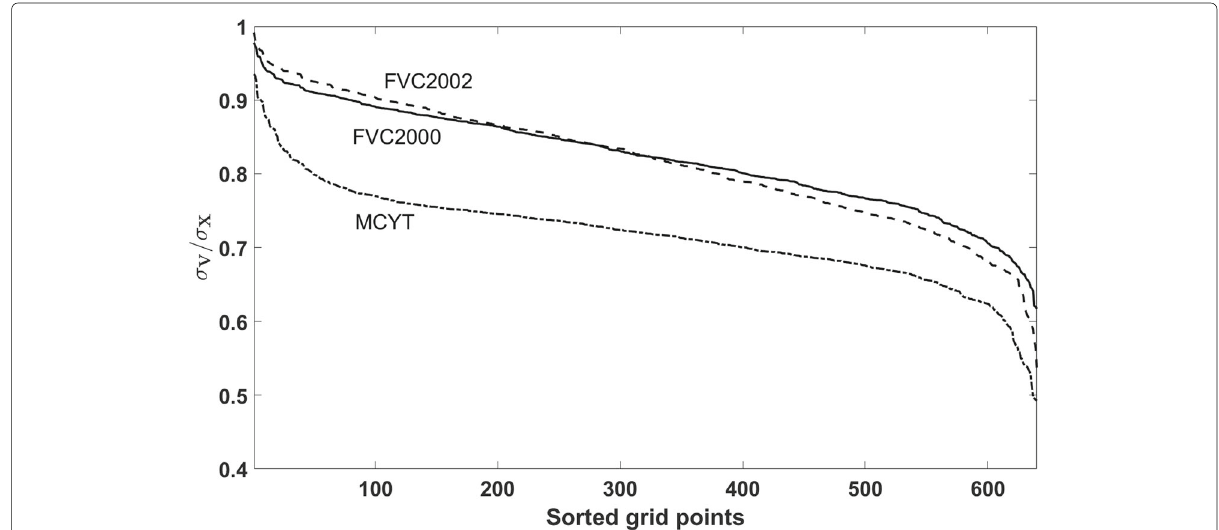
Fig. 8 Sorted noise-to-signal ratio of M x β for different